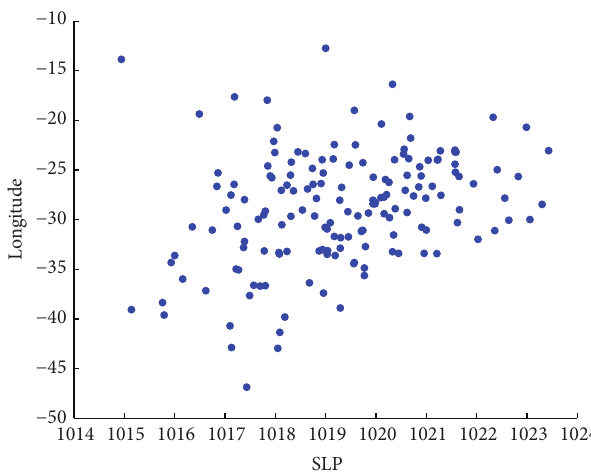
Figure 5: Monthly mean Azores High pressure (mb) and longitude (degrees east) for DJF